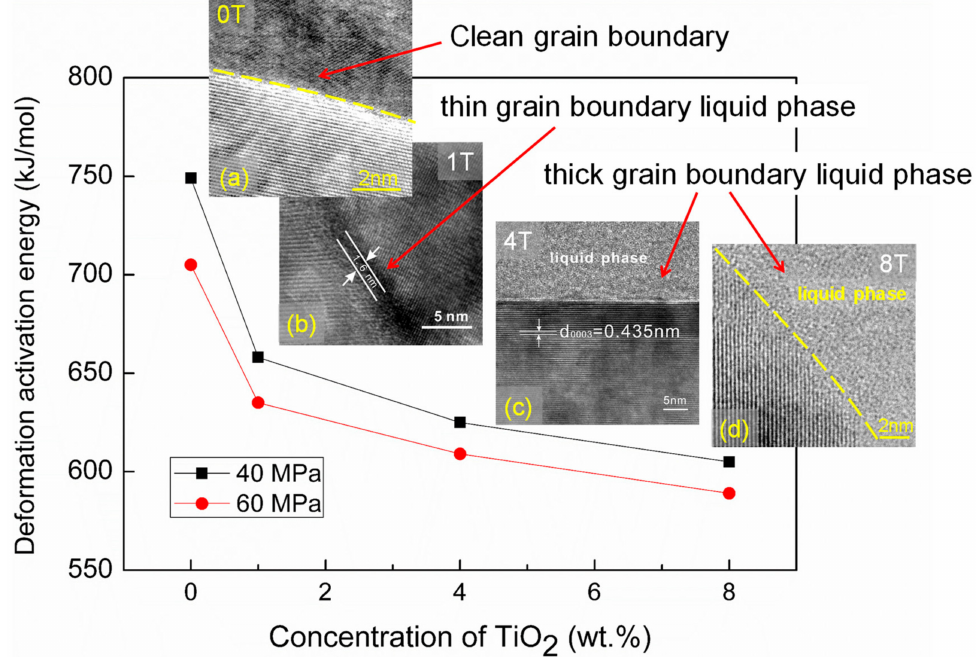
Figure 6. The relationship between deformed apparent activation energy and grain boundary feature in the four TiO 2 -doped ZTA ceramics. Grain boundary features were determined by high resultion TEM (HR-TEM) micrographs at typical grain boundaries. Three grain boundary features were observed, named the clean grain boundary ( a ) in 0T, thin liquid phase ( b ) in 1T, and thick liquid phase ( c – d ) in 4T and